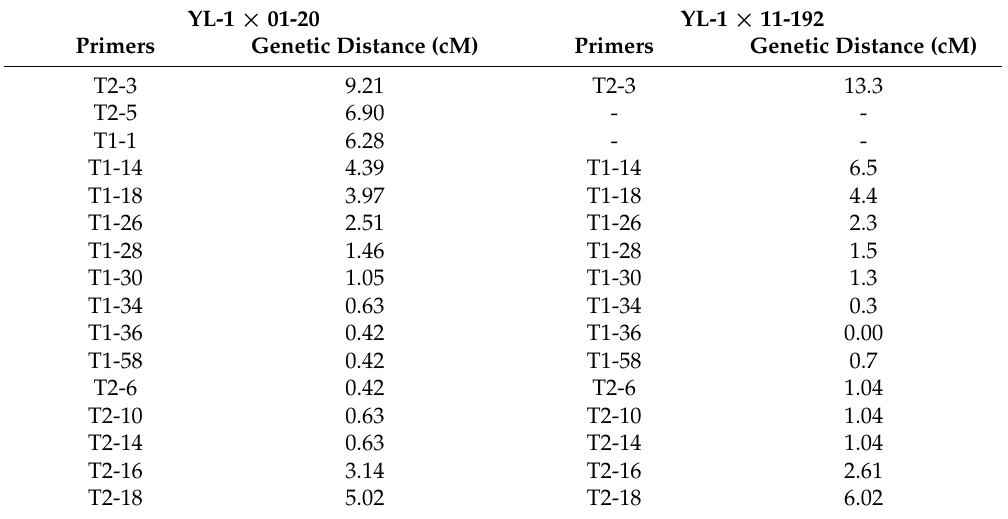
Table 1. Genetic distances of the InDel primers to the ygl-1 in the two mapping